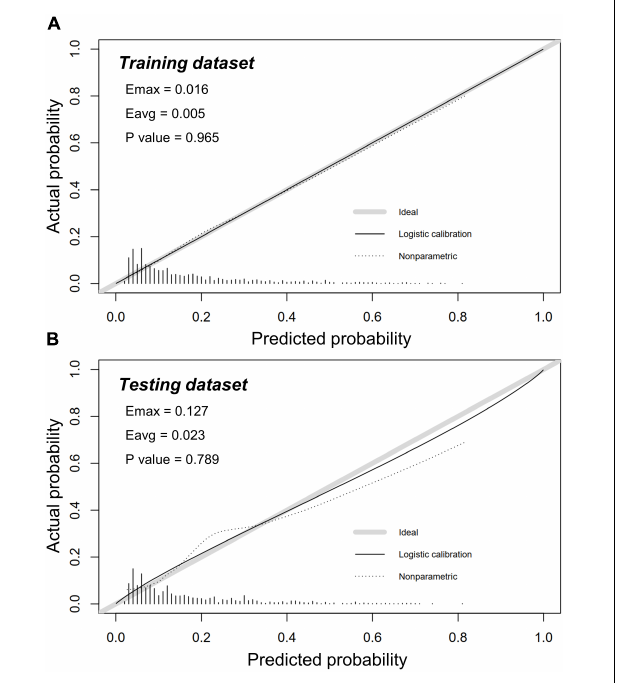
FIGURE 5 | Calibration plots in training and testing dataset. Calibration plots showed excellent accuracy of the absolute risk prediction in panel (A) the training dataset ( P = 0.965) and (B) the testing dataset ( P = 0.789). If the nomogram has a good calibration, a 45-degree diagonal line will be presented between the actual rate of CA-AKI ( y -axis) and the predicted probability of CA-AKI ( x -axis). P > 0.05 indicates a good calibration with no difference between the actual rate and predicted